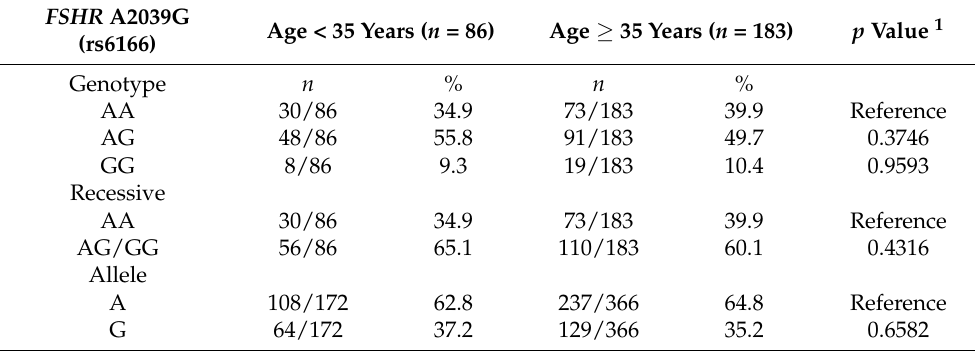
Table 3. The frequencies of FSHR A2039G (rs6166) SNP among women with serum AMH < 1.2 ng/mL in varied age